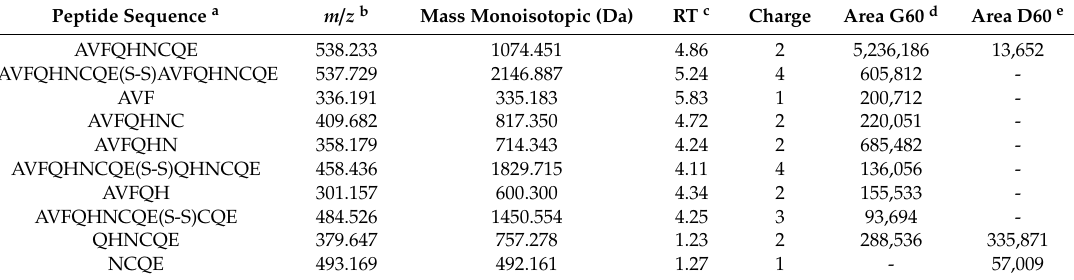
Table 2. Identified sequences from the in vitro digestion of the peptide AVFQHNCQE. Peptide Sequence a m / z